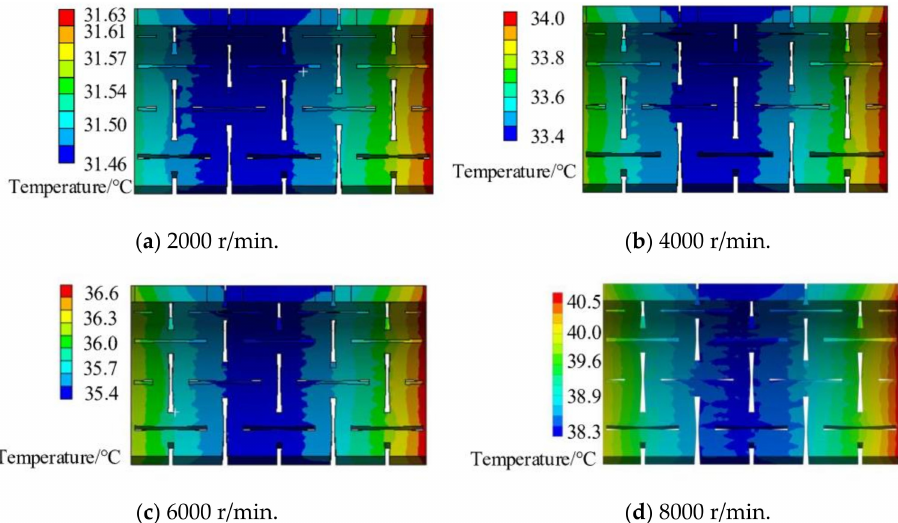
Figure 10. Temperature fields of NPR spacer at different speeds. ( a ) Temperature field of NPR spacer with speed of 2000 r/min, ( b ) Temperature field of NPR spacer with speed of 4000 r/min, ( c ) Temperature field of NPR spacer with speed of 6000 r/min, ( d ) Temperature field of NPR spacer with speed of 8000